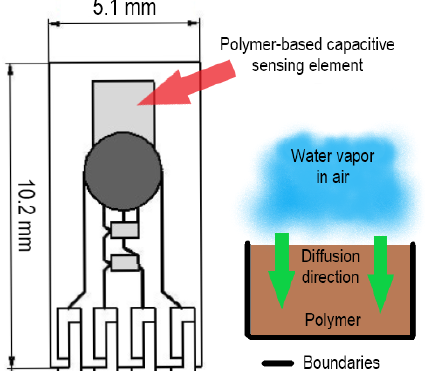
Figure 3. Closeup of the IST HYT-271 capacitive sensor with di- mensions (left) and sensing element configuration (right). Left im- age taken from